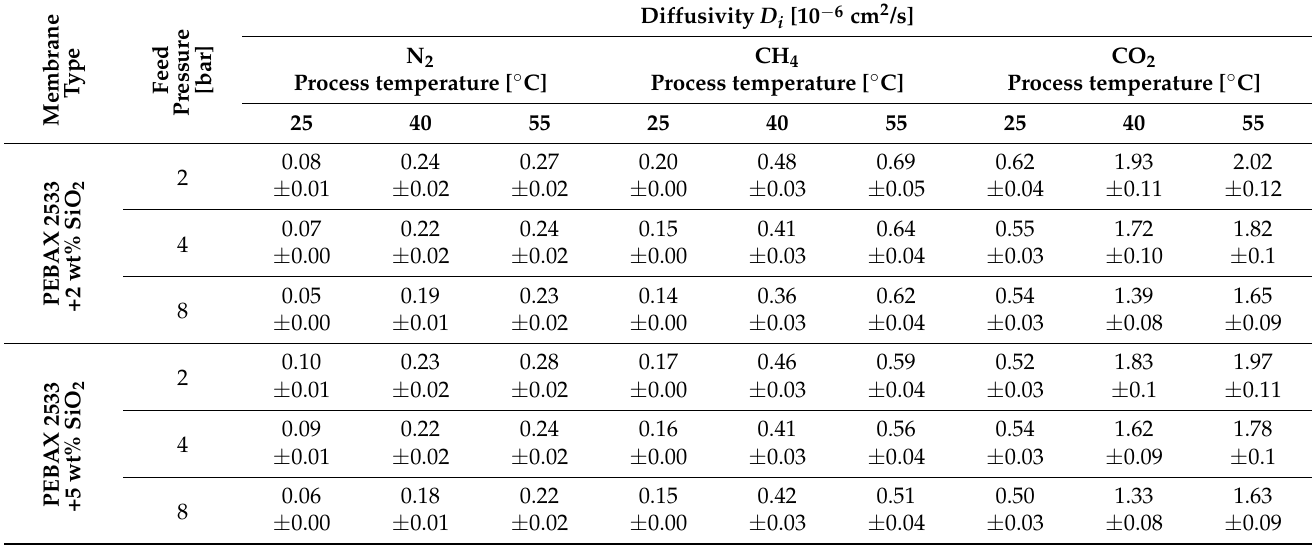
Table A6. Diffusion coefficient of heterogeneous membranes containing SiO 2 to different gases measured for different feed pressure and temperature values.